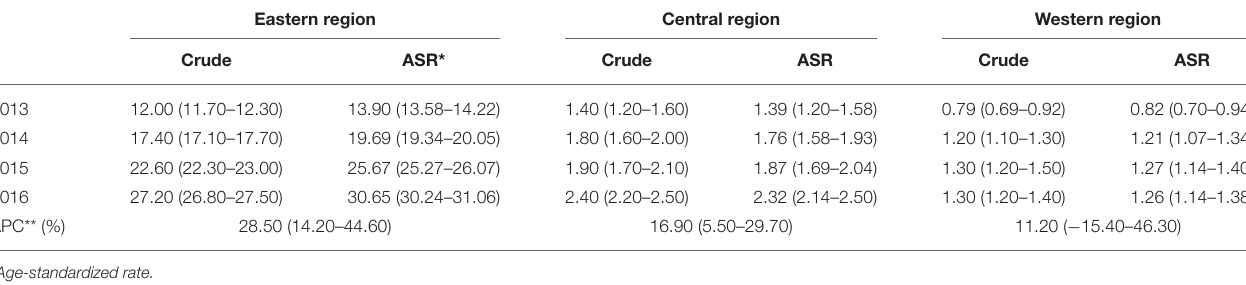
TABLE 9 | Annual crude and age-standardized prevalence rate of ulcerative colitis among urban employees in three regions of China from 2013 to 2016 (per 100,000 persons). Eastern region Central region Western region Crude ASR* Crude